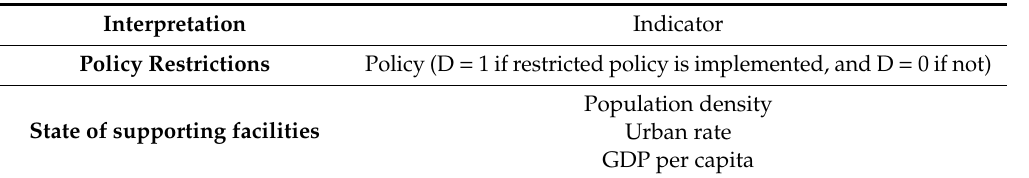
Table 7. Indicators for cluster analysis.